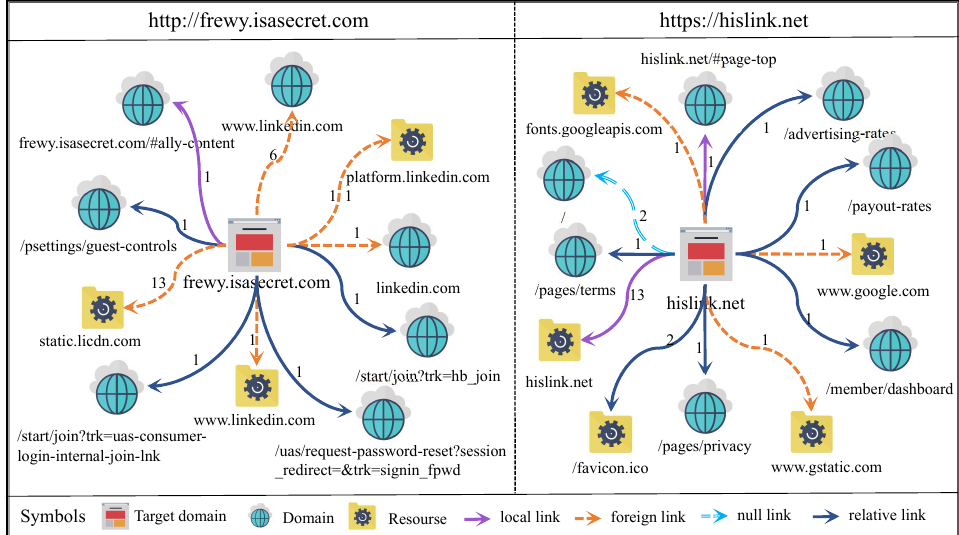
Figure 5. Instances of different